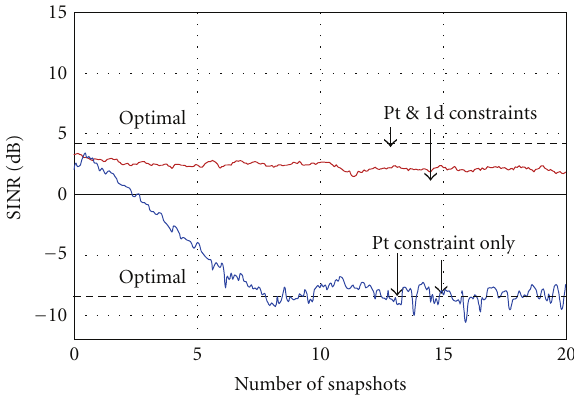
Figure 8: Learning curves for GSC with DOA mismatch utilizing point constraint only and first-order derivative constraint